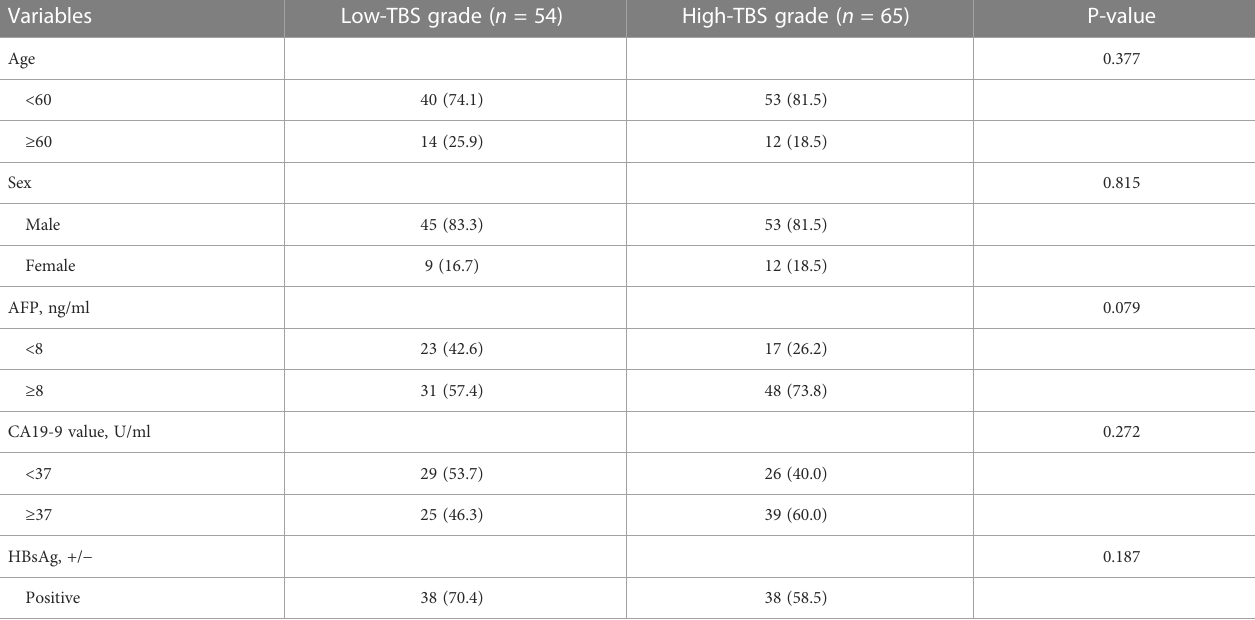
TABLE 2 Correlation between TBS grade and clinicopathological characteristics in training cohort.